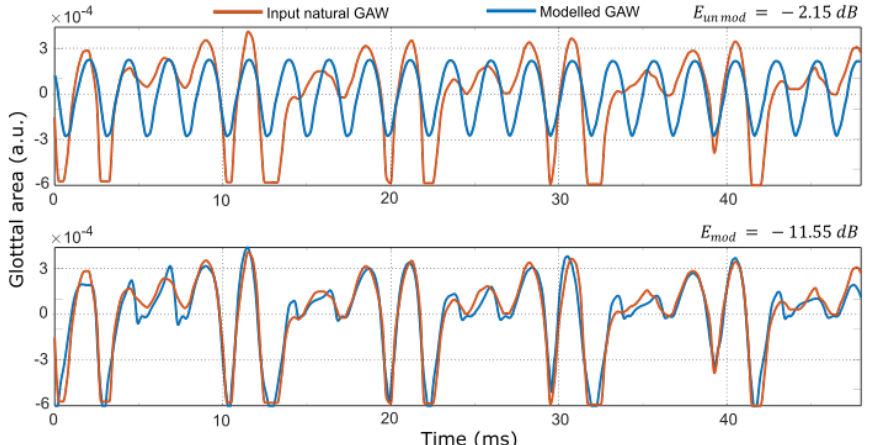
Figure 5. Modelling of an example of an amplitude modulated vocal fry GAW using the nonmodulating model (top plot) and the modulating model (bottom plot).